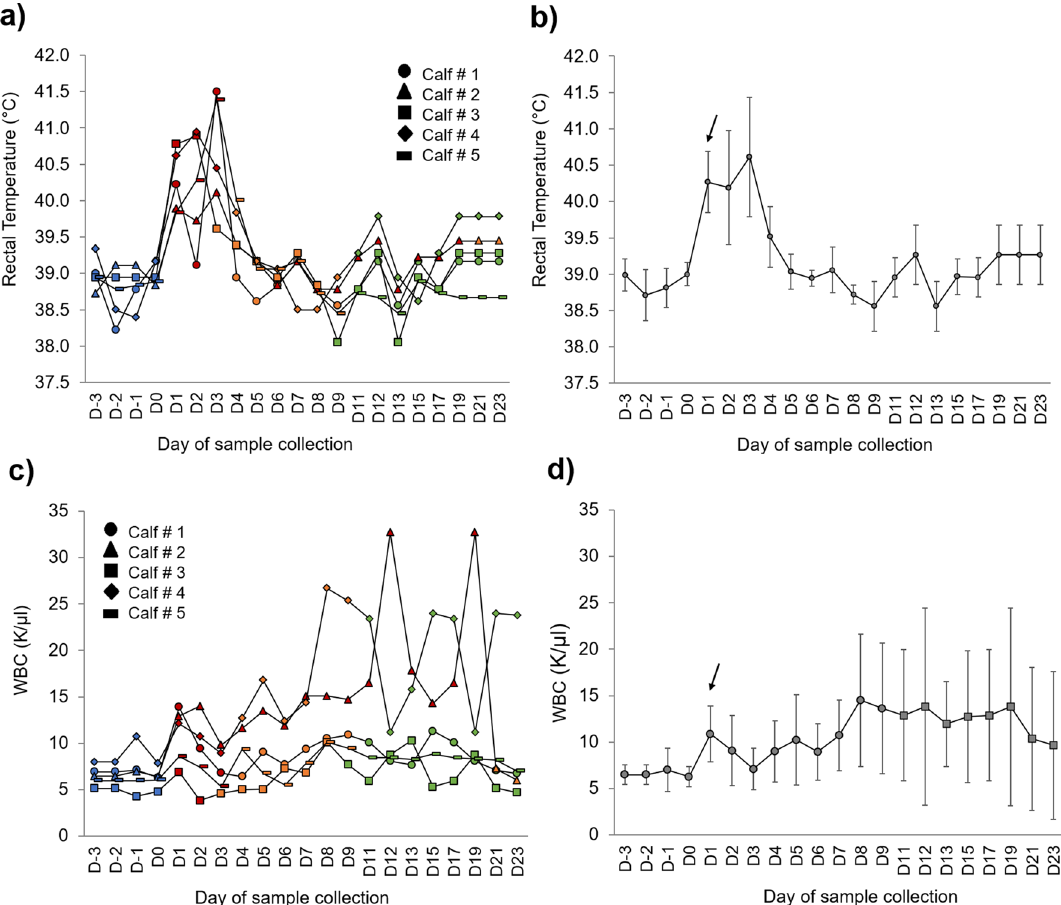
Figure 1. Dairy Calves (n = 5) response to M. haemolytica infection across the 23 days of the study . ( a ) Daily rectal temperature (°C) per calf. ( b ) Rectal temperature shown as Mean ± SD. The baseline days are in blue, infected days in dark red, the days of antibiotic treatment in orange, and the recovered days are in green. ( c ) White blood cell count (thousands per cubic milliliter, K/µl) per calf. ( d ) WBC showed as Mean ± SD. A characteristic increase 24 h after the challenge (D0, indicated by arrows) can be seen due to the activation of the innate immunity or nonspecific defense mechanisms against M. haemolytica virulence